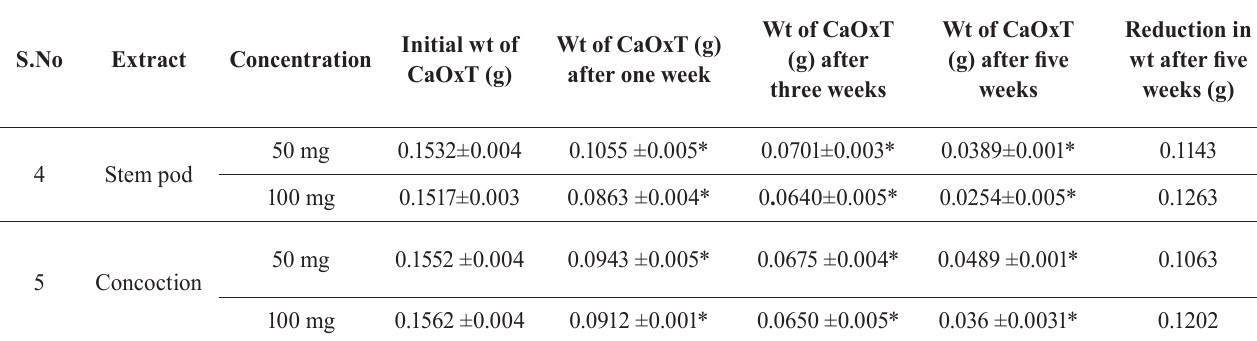
TABLE II - Weight of calcium oxalate tablet before and after treatment